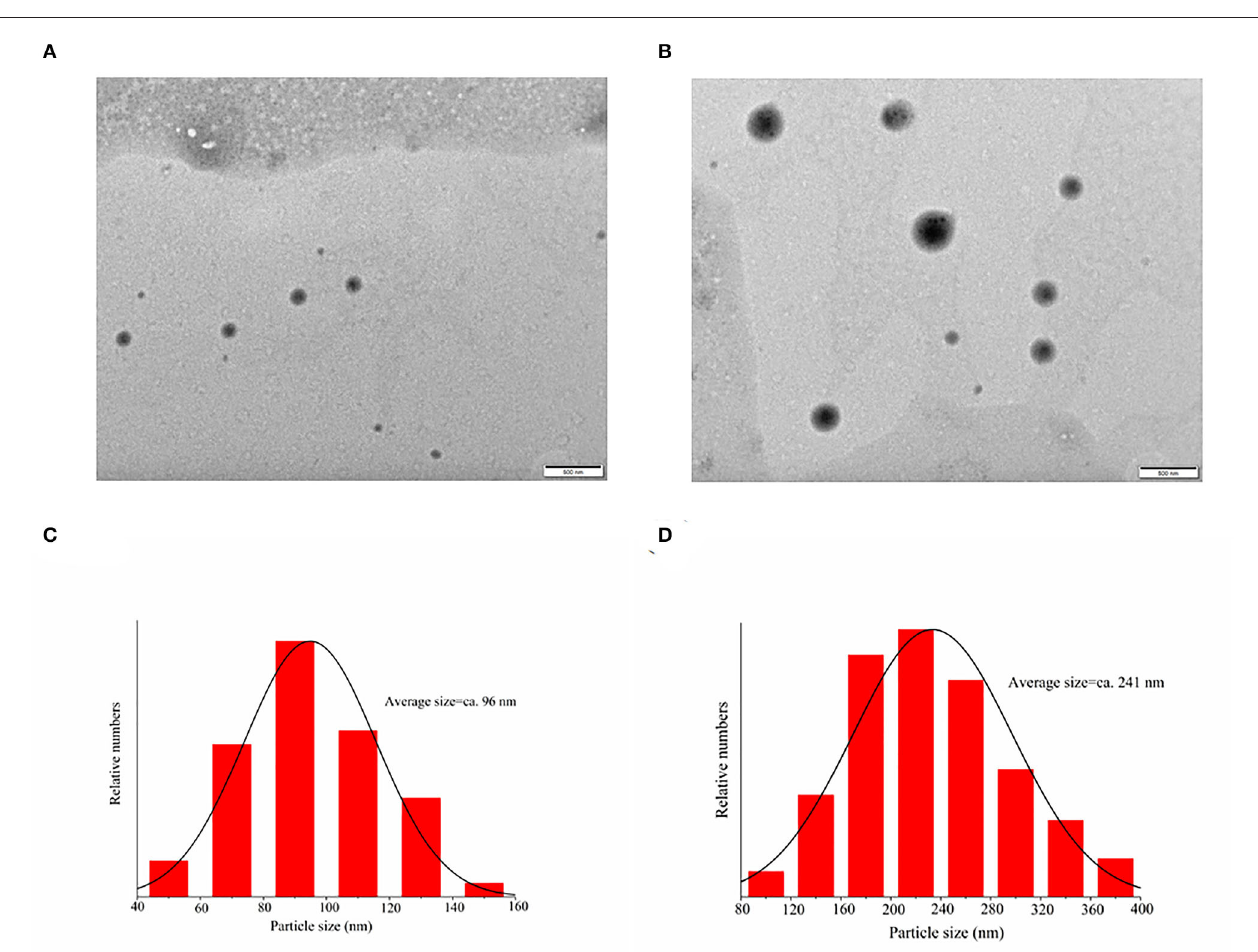
FIGURE 6 | Transmission electron microscopy images of (A) PEC NPs; (C) lycopene-loaded PEC NPs; (B) and (D) are the size distribution histograms of images.